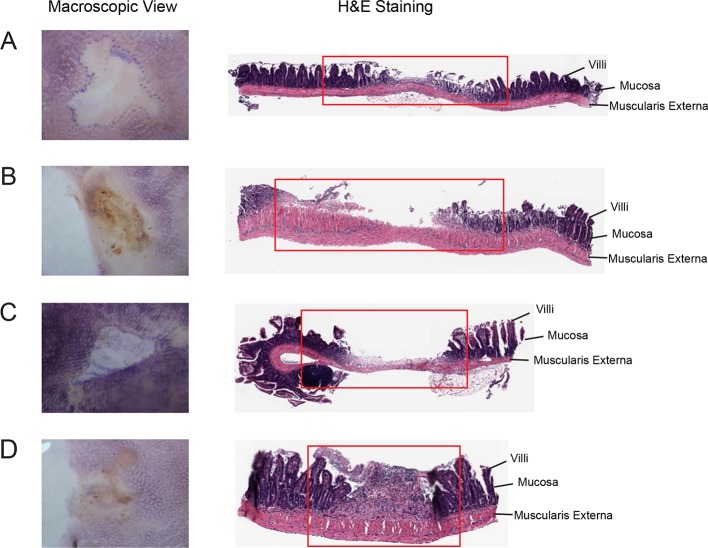
Indomethacin induces small intestinal damage in C57BL/6 mice.Representative sections of small intestinal injuries 24 hr after 10 mg/kg indomethacin treatment, including macroscopic views (left) and hematoxylin and eosin (H&E) staining (right). Macroscopically identified lesion areas were cut out for histopathology analysis by H&E staining at the center of the area. Red rectangle outlines the mucosal erosion (A) and ulcerations (B-D) observed.